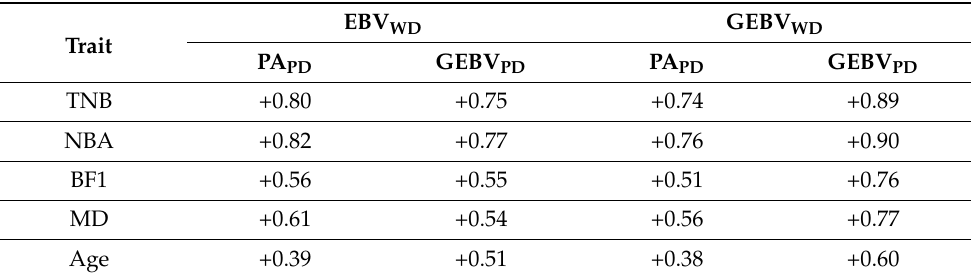
Table 4. Correlation coefficients of final genomic and genetic estimates (EBV WD , GEBV WD ) with preliminary predictions (PA PD , GEBV PD ) of the validated